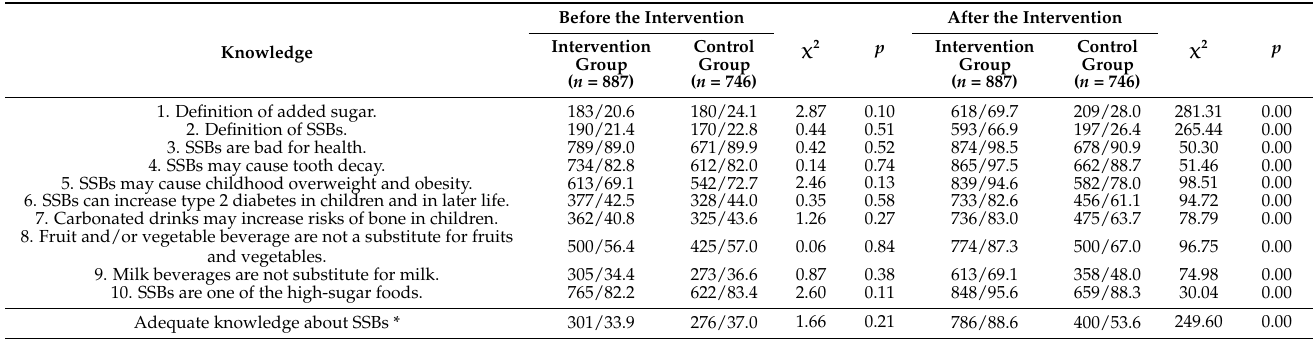
Table 3. Knowledge awareness rate of sugar-sweetened beverages (SSBs)